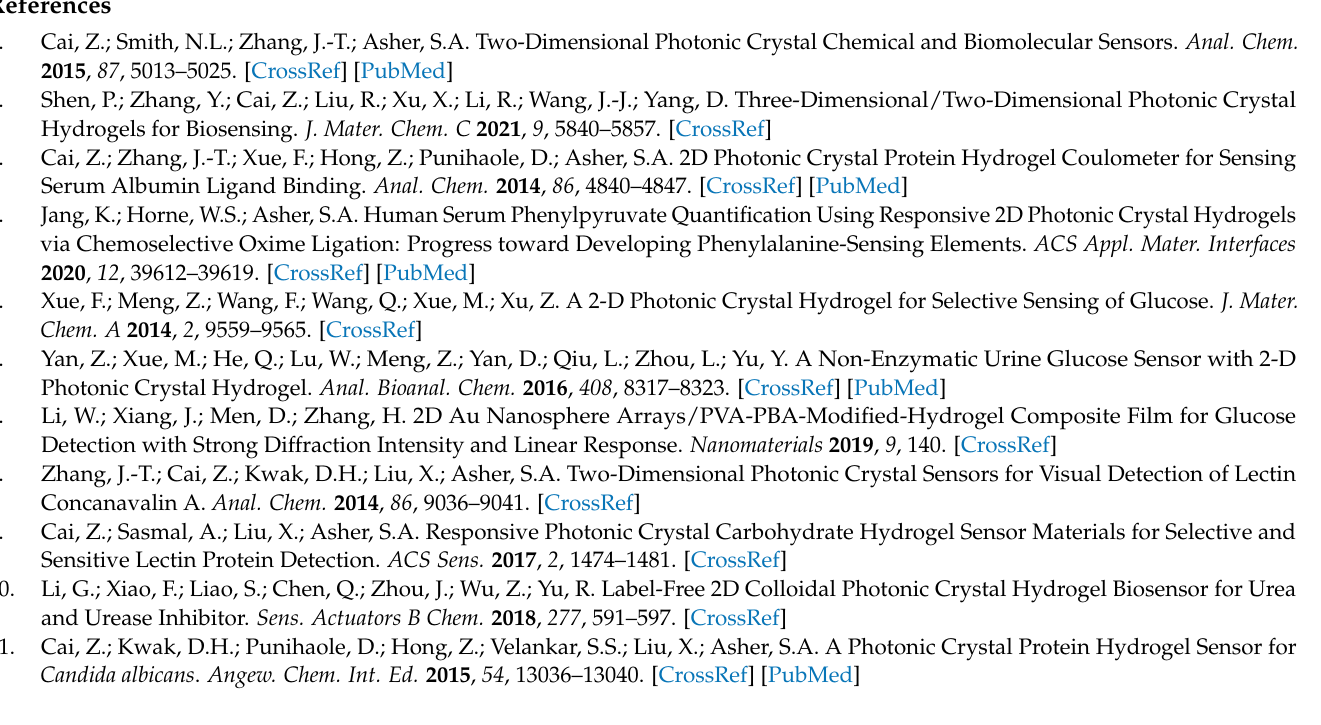
Ring; Figure S2: The Effect of the Modified-Aptamer Concentration on the Particle Spacing Changes; Figure S3: XPS Characterization; Figure S4: Calculation of LoD; Figure S5: The Particle Spacing Changes of Aptasensors at Different Lysozyme Concentrations; Figure S6: Sensitivity of DNA- H1-500 for Detecting Lysozyme; Table S1: The Raw Data of DNA-H1-960 for the Detection of Lysozyme in Human Serum; Table S2: Detection Performance Comparison of Different Sensors for Lysozyme